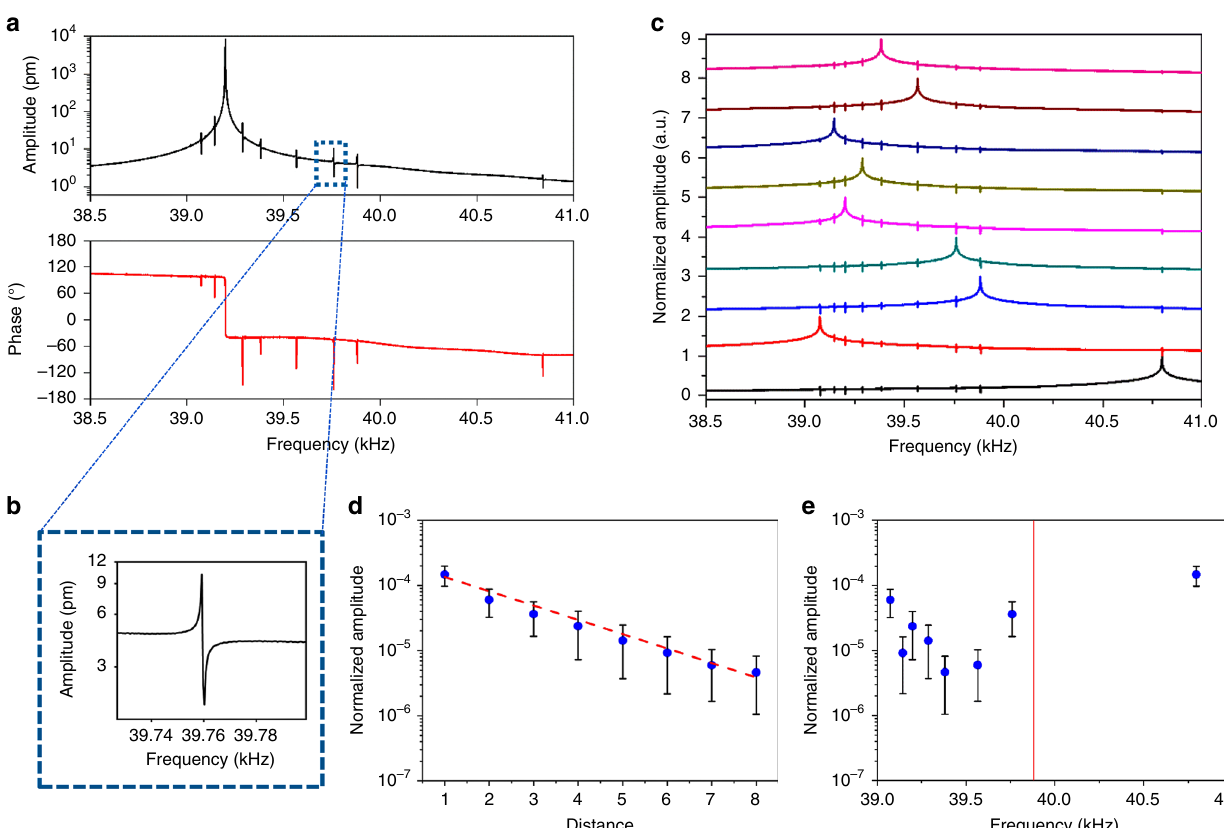
Fig. 1 Measured weak-coupling in a nanomechanical cantilever array. a Amplitude and phase response of a single cantilever, showing the asymmetric weak-coupling peaks which are related to the other resonators of the array; see sub fi gure ( c ). b Magni fi ed view of the asymmetric amplitude peak contained in the dotted box of sub fi gure ( a ). c Amplitude response of all nine cantilever resonators of the array, showing coincidence of the weak-coupling peaks with primary resonances of other cantilevers. Vibration spectra are normalized and shifted in amplitude for clarity. d Average peak-to-peak amplitudes of all weak-coupling asymmetric peaks as a function of the corresponding distance (of the cantilever related to that peak) to the cantilever being measured; line of best fi t shown. e Average peak-to-peak amplitudes of the weak-coupling peaks as a function of frequency; no correlation is evident. Measurements on each cantilever are reported in Supplementary Table